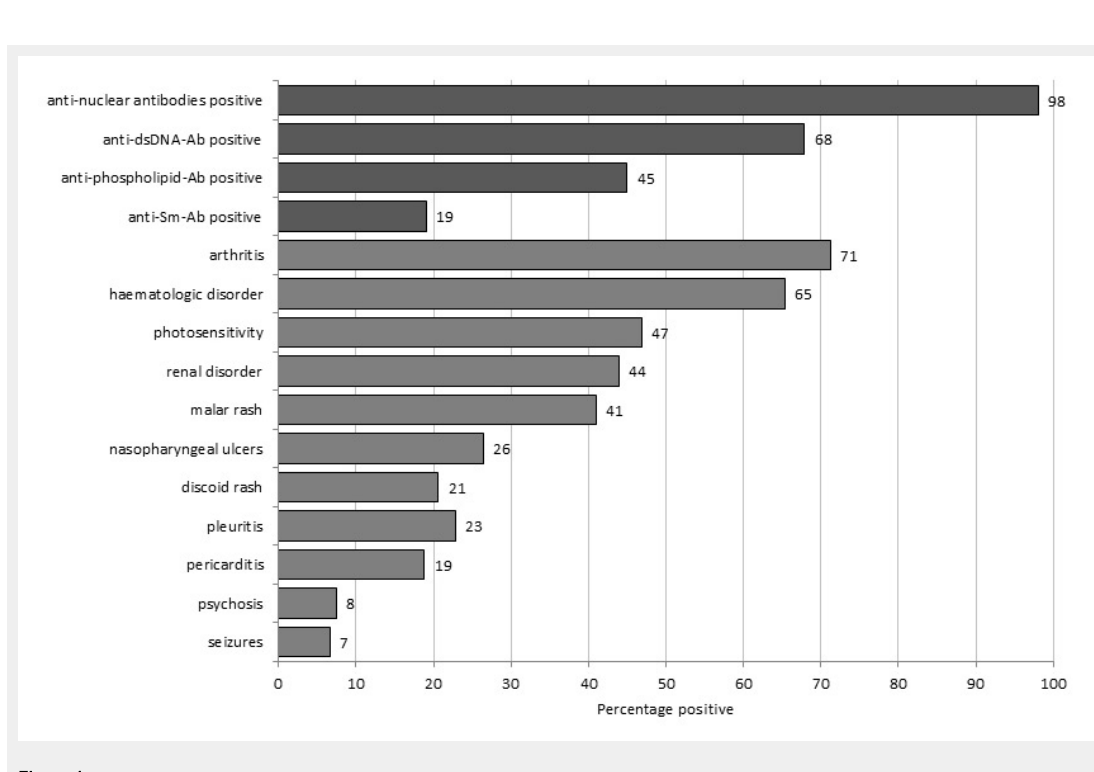
Figure 1 American College of Rheumatology Criteria fulfilled at inclusion in 255 patients with systemic lupus